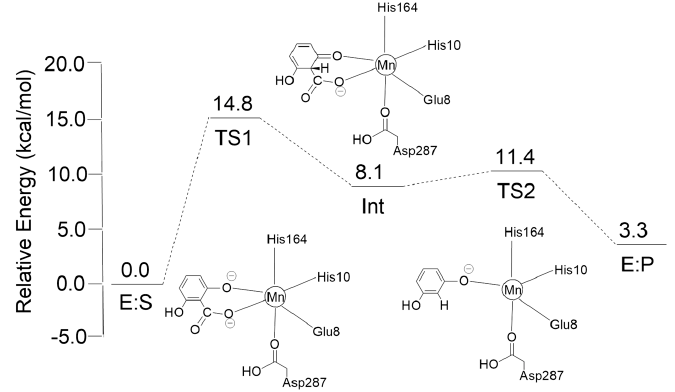
Figure 14. Structures of E:S (enzyme-substrate) complex, E:P (enzyme-product) complex, and Int (intermediate) complex. Calculated energy profile for the proposed reaction mechanism. Reprinted with permission from [54]. Copyright 2018, American Chemical Society.